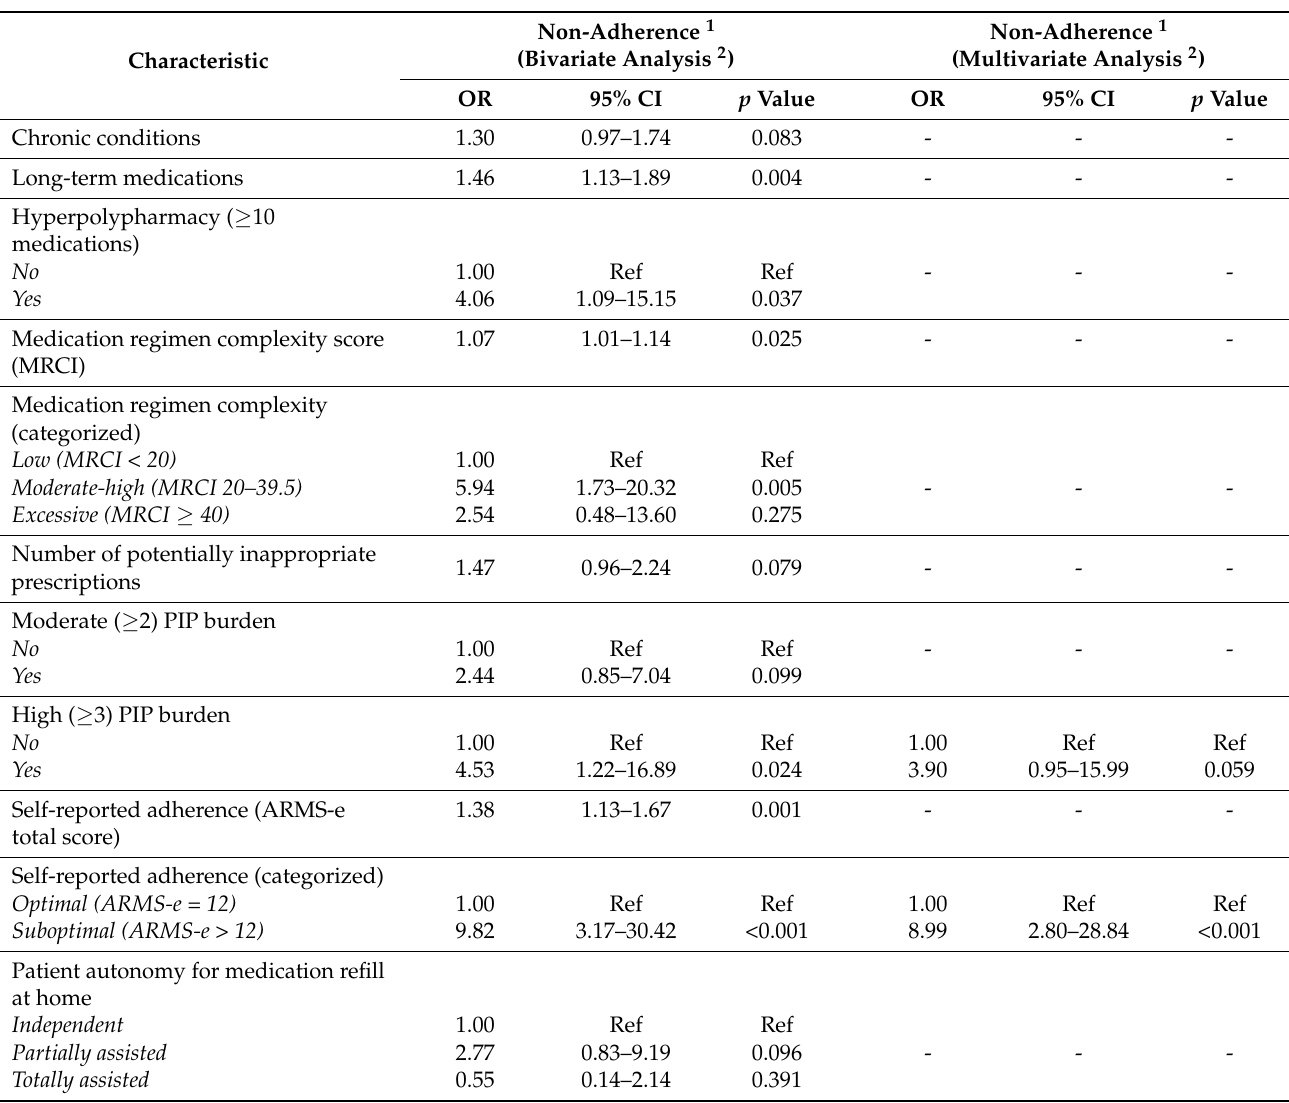
Table 2. Logistic regression examining factors associated with medication non-adherence in older patients with multimor- bidity and polypharmacy admitted to an intermediate care